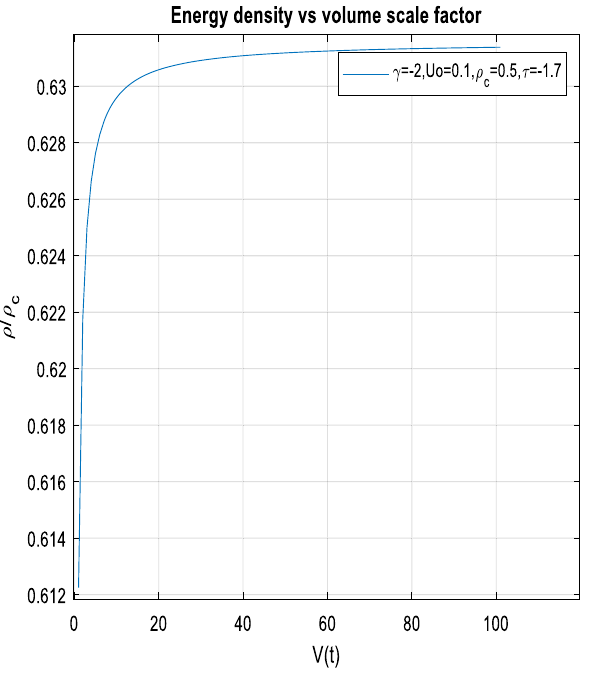
Fig. 6 Graph for energy density; γ = − 2 ; U 0 = 0 . 5 ; τ = − 1 .